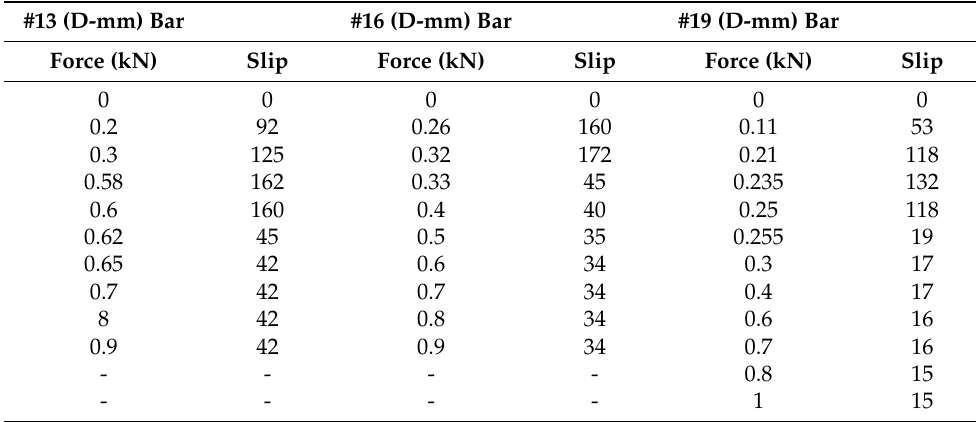
Figure 6. Typical Pullout test samples after failure: ( a ) #16 D bar; ( b ) #13 D bar; ( c ) 19 D bar. Table 6. The main results of pullout test samples for bond length 10 d b .